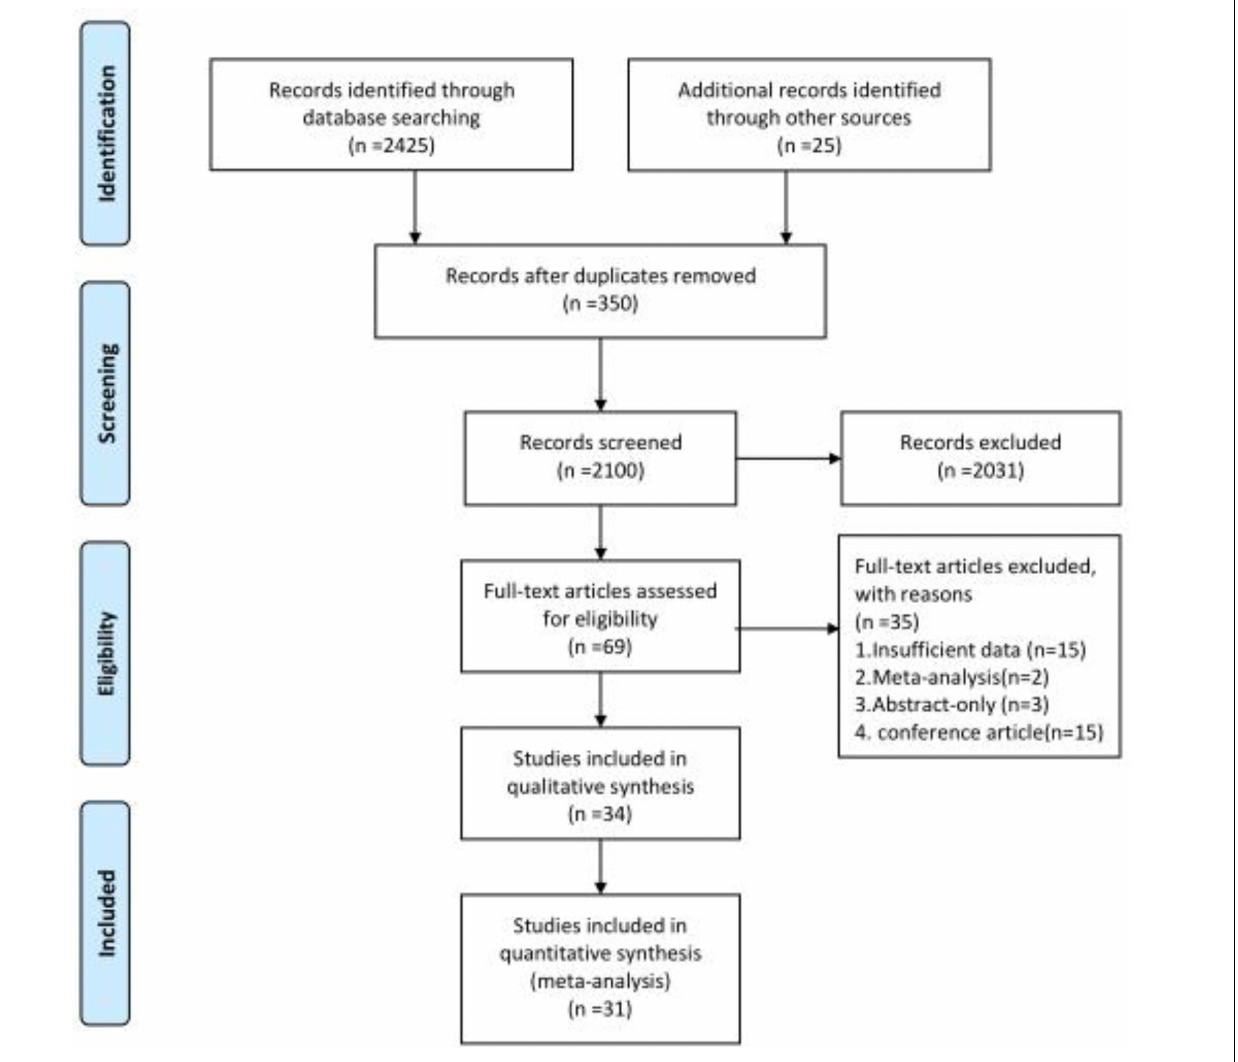
FIGURE 1 | Preferred Reporting Items for Systematic Review and Meta-Analyses (PRISMA) flowchart of included articles.